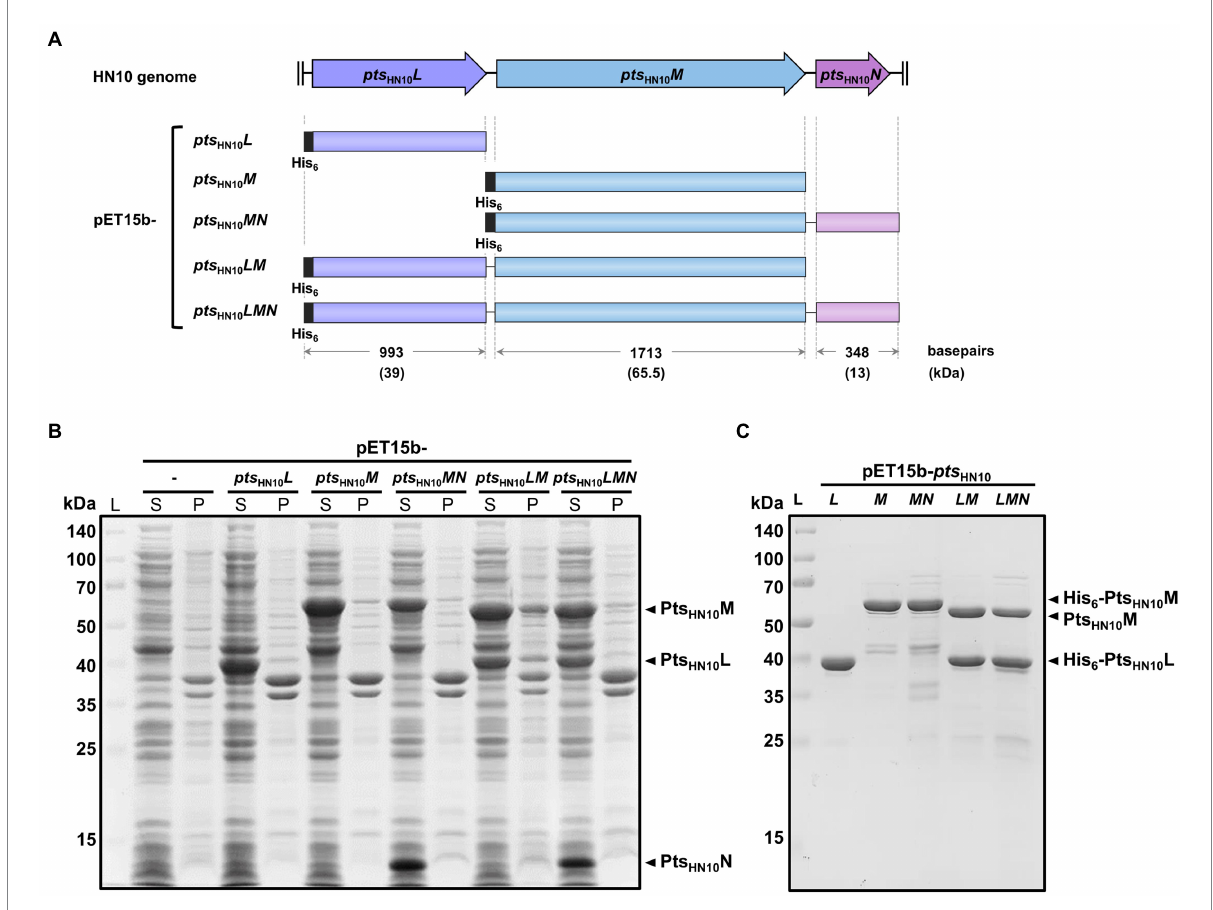
FIGURE 1 Expression and purification of Pts-related constructs from the HN10 prophage. (A) The schematic representation of five constructs from the HN10 prophage. The horizontal boxes indicate the insert sequences covering three genes of interest ( pts HN10 L , pts HN10 M , and pts HN10 N ). The plasmid nomenclature, sequence length (base pairs), and expected molecular mass of proteins (kDa) with hexahistidine-tag are shown. (B) SDS-PAGE analysis shows the total protein expression of five pET15b constructs in E. coli . The empty vector of pET15b serves as a control. The expected bands of overexpressed Pts HN10 L, Pts HN10 M, and Pts HN10 N proteins are indicated by black arrowheads. L, protein ladder; S, supernatant; P, pellet. (C) The SDS-PAGE analysis demonstrates the purified proteins after Ni-NTA affinity chromatography. The expected bands of Pts HN10 L and Pts HN10 M proteins are indicated by black arrowheads. L, protein